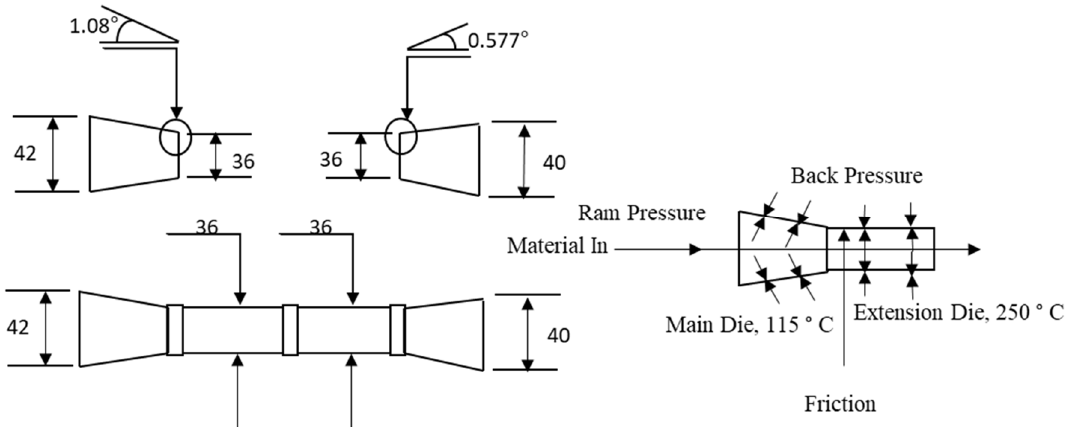
Figure 4. Die configuration schematic of pilot scale briquette press (diameter in mm).